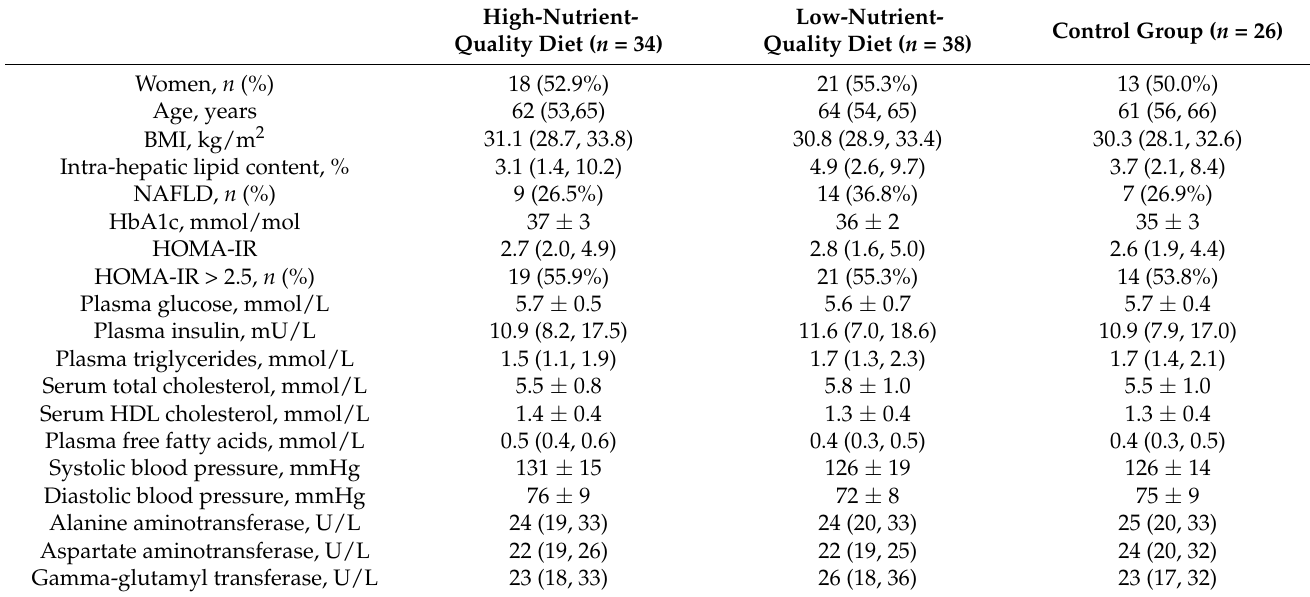
Table 1. Baseline characteristics of study participants with available FGF21